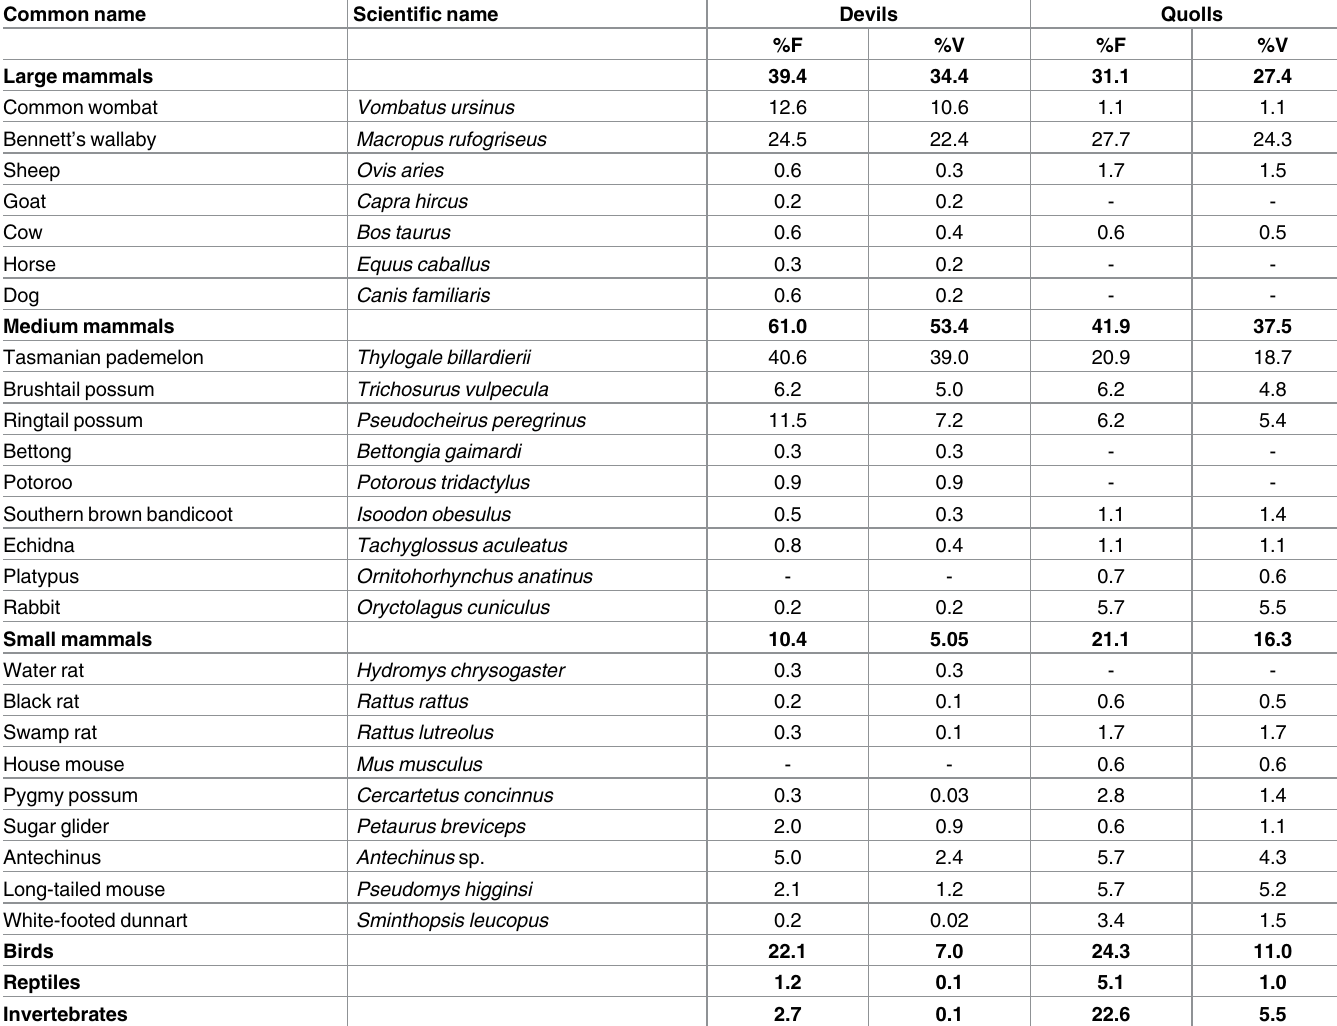
Table 2. Percent frequency occurrence (%F) and relative volume (%V) of prey items in the diets of Tasmanian devils (n = 902 prey items and 660 scats) and spotted-tailed quolls (n = 258 prey items and 177 scats), across Tasmania,